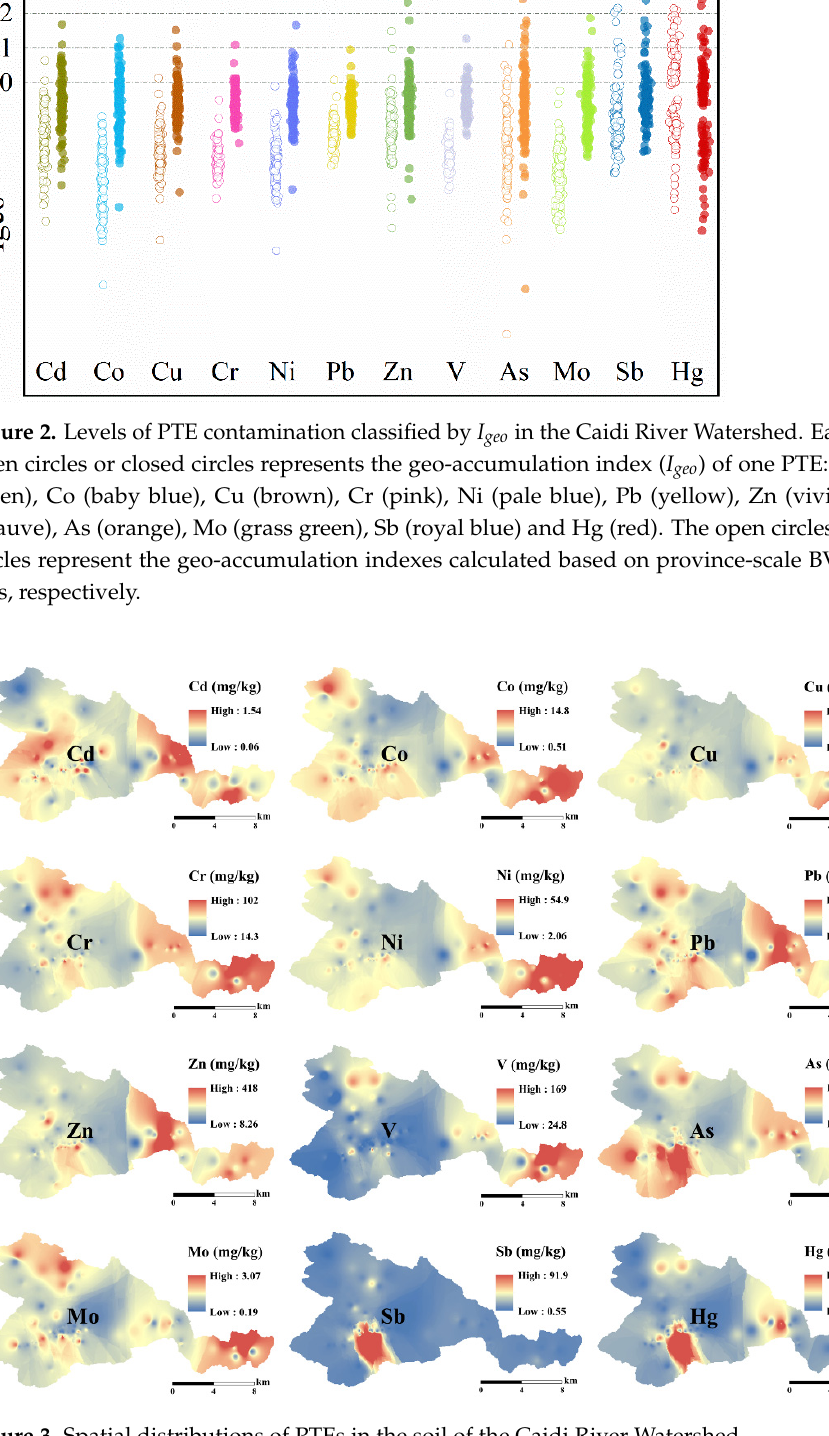
Figure 3. Spatial distributions of PTEs in the soil of the Caidi River Watershed.